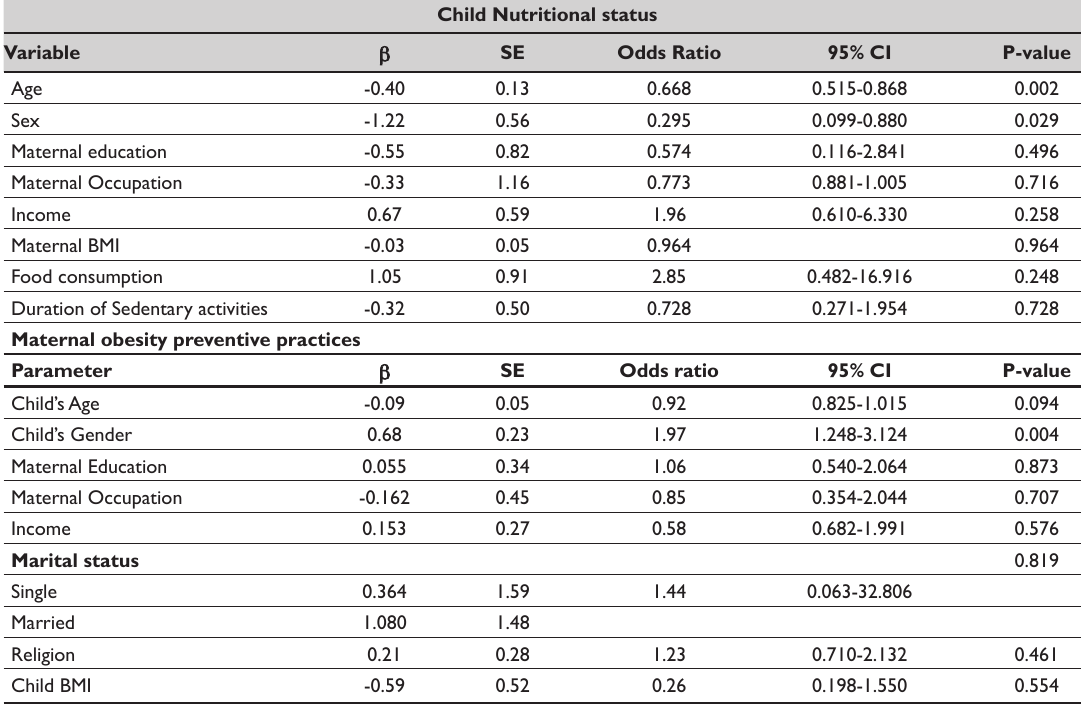
Table 6: Logistics regression analysis of determinants of child nutritional status and maternal preventive practices against childhood obesity Child Nutritional